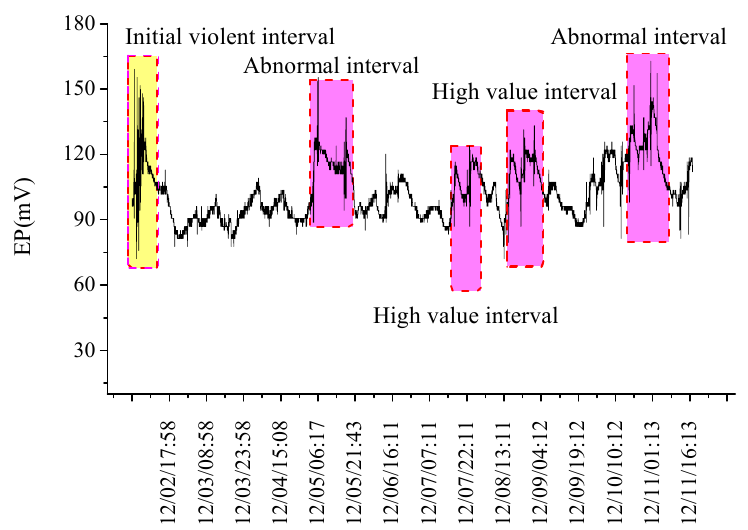
Figure 4. Measuring results of EP signal behind the driving face along with driving distance.